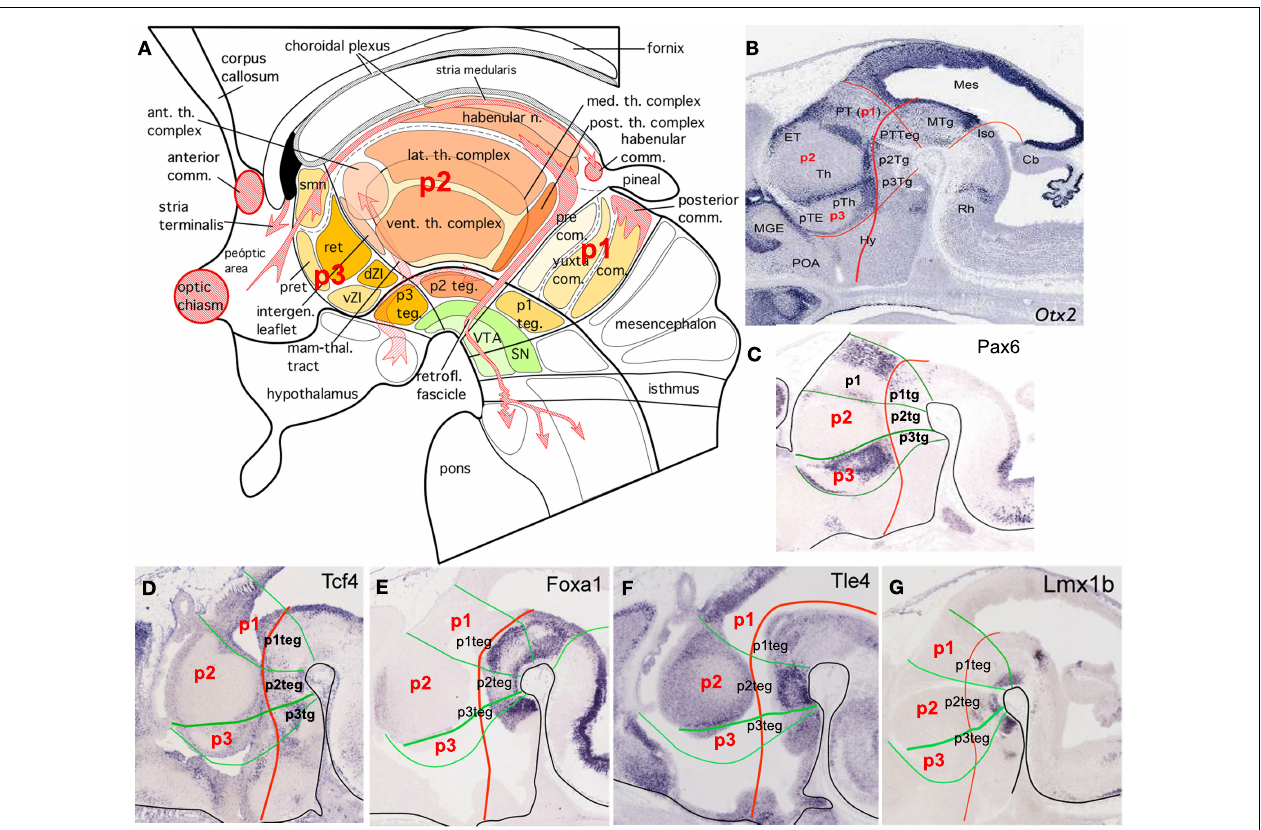
FIGURE 3 | (A) Schematic representation that summarizes the different nuclei and structures in the mammalian diencephalon. Major nuclear subdivisions of alar and basal plate and the main axonal tracts, which cross the three domains of the diencephalon, are also represented (modified from Puelles et al., 2008). (B–G) Expression patterns of several genes defining the different compartments of the diencephalon at E14.5 (Eurexpress). Otx2 , orthodenticle homeobox 2 is expressed in the boundary between the embryonic thalamus and prethalamus, in the boundary between the pretectum and thalamus, in the p3 zona incerta and in the liminal part of the alar p2.; Pax6 , paired box 6 is expressed in the commissural pretectum and in the prethalamus; Tcf4 , transcription factor 4 is expressed in the ventricular epithelium of the alar and basal diencephalon; Foxa1 , forkhead box A1 is expressed in the basal plate of the diencephalon; Tle4 , transducin-like enhancer of split 4 is expressed strongly in the mantle layer of the p2 basal plate and weakly in the mantle layer of the prethalamus, epithalamus, and pretectum; Lmx1b , LIM homeobox transcription factor 1-beta is expressed in the basal plate of